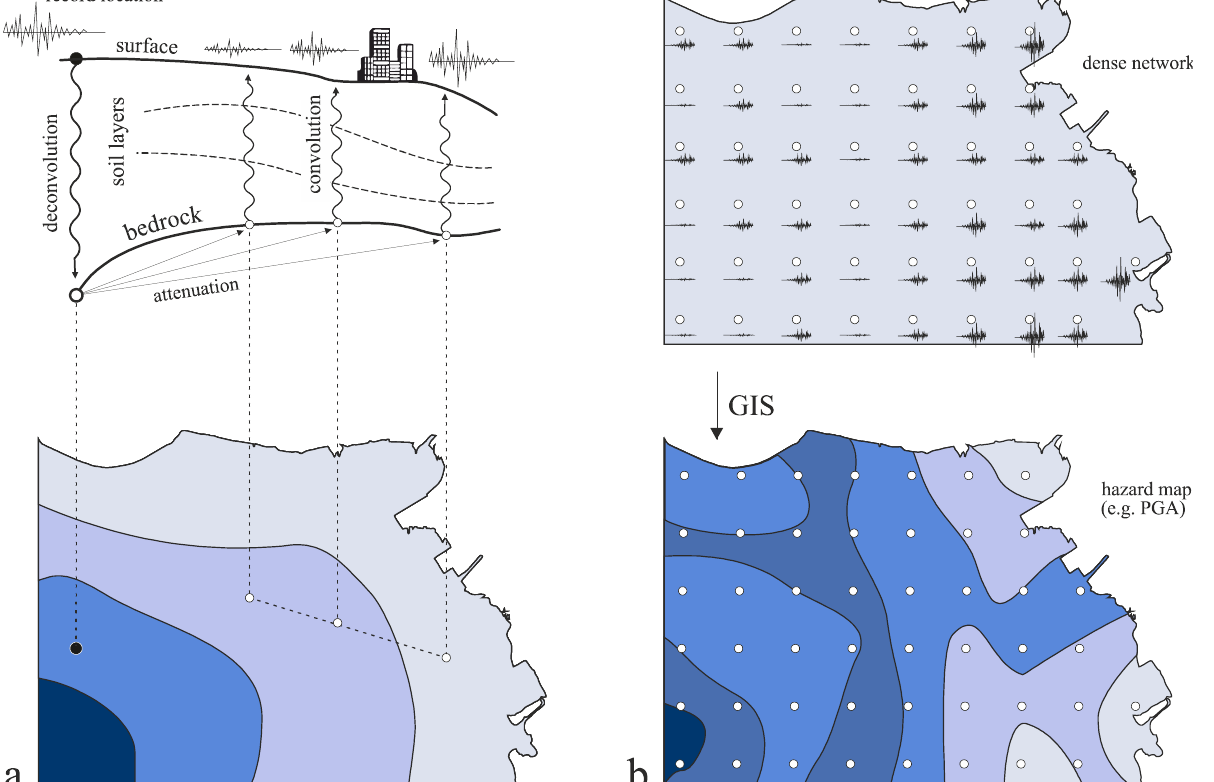
Figure 1. ( a ) Microzonation procedure and ( b ) suggested methodology.